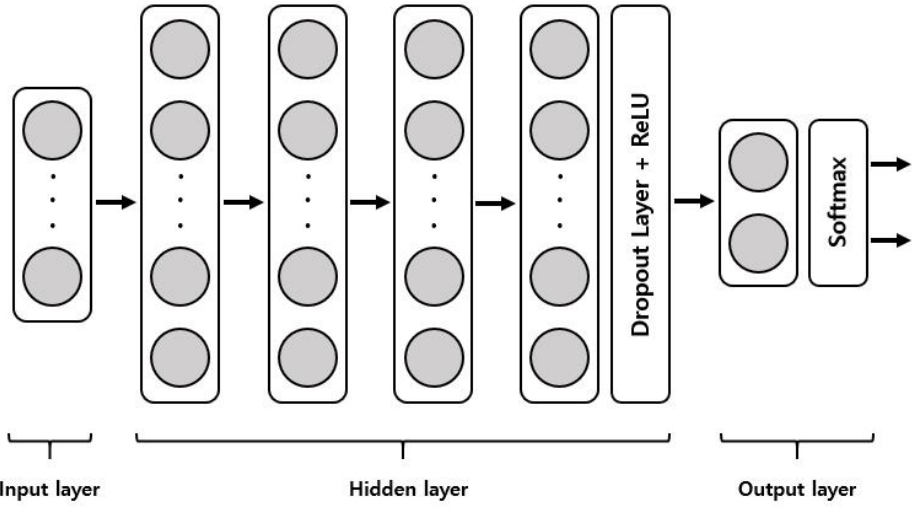
Figure 3. Structure of our DNN model.